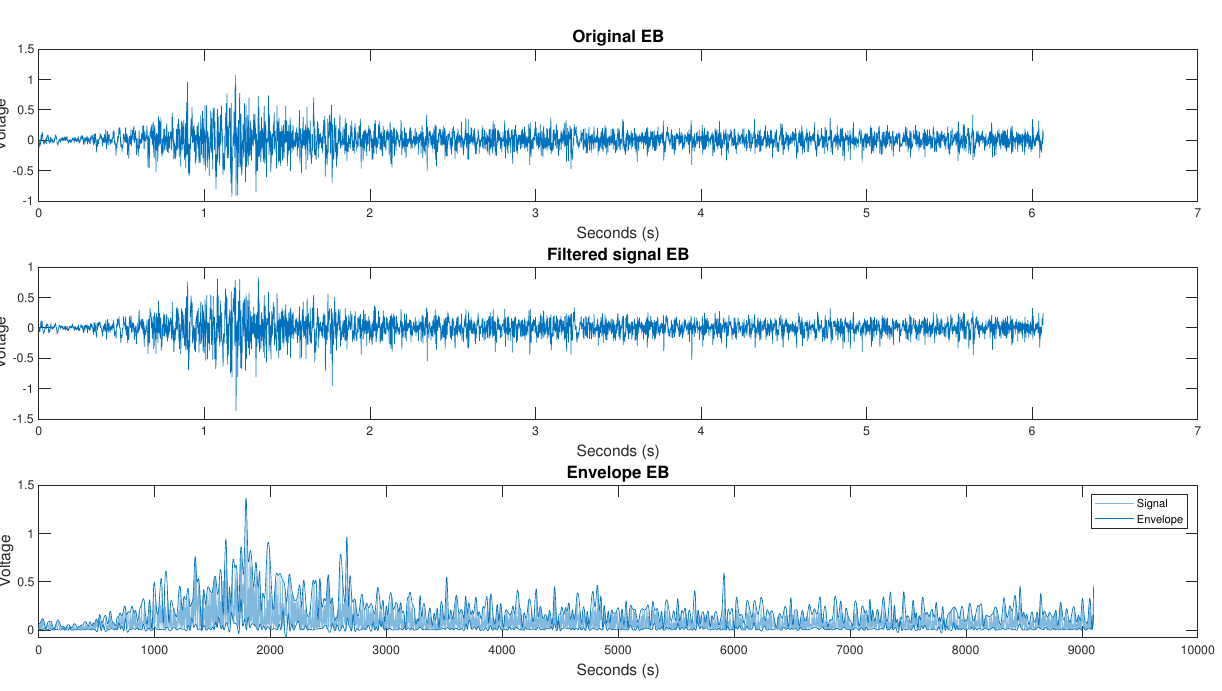
Figure 5. Original, filtered, and surround signal from channel 1, person 1, and test 1 for the toe-off movement.